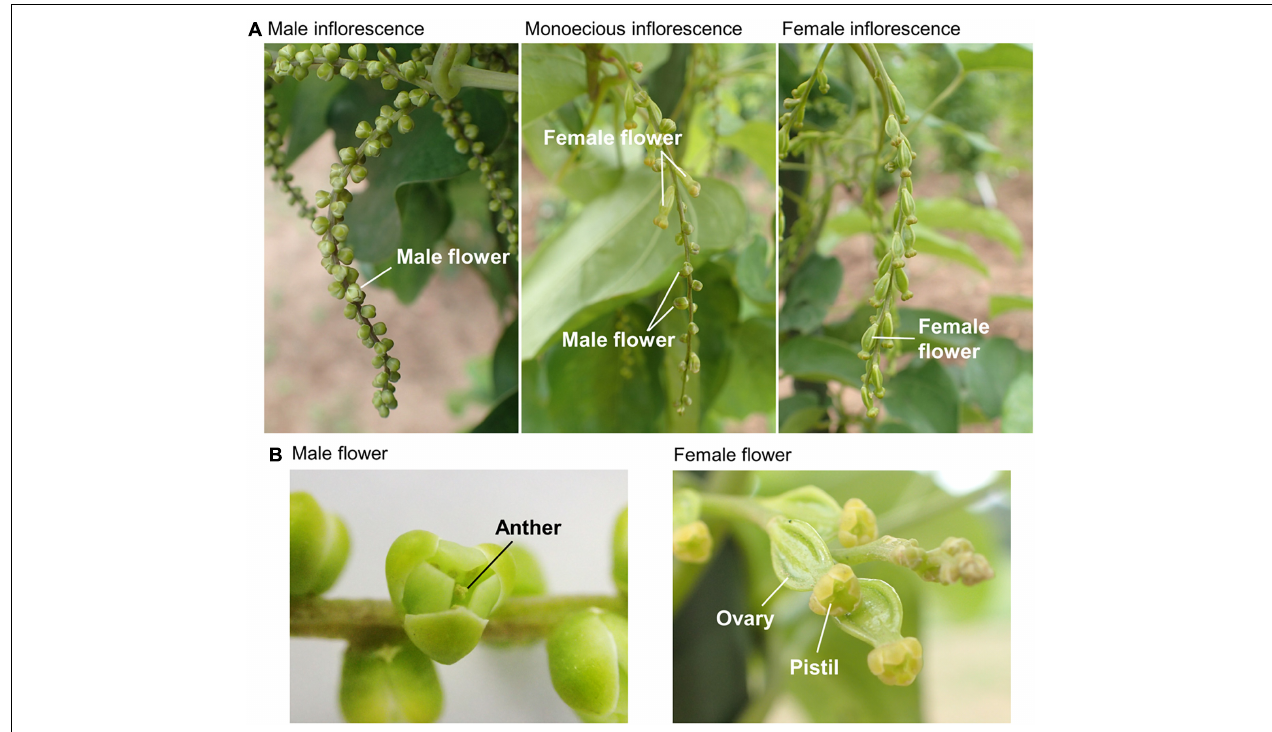
FIGURE 2 | Sex phenotypes in Dioscorea rotundata . (A) Photos of male (left) , female (right) , and monoecious (center) inflorescences taken at the experimental field in IITA were shown. Male and female inflorescences consist only of male and female flowers, respectively. A plant of the first type monoecious has inflorescences with both male and female flowers. (B) Macro photos of the male (left) and female (right)